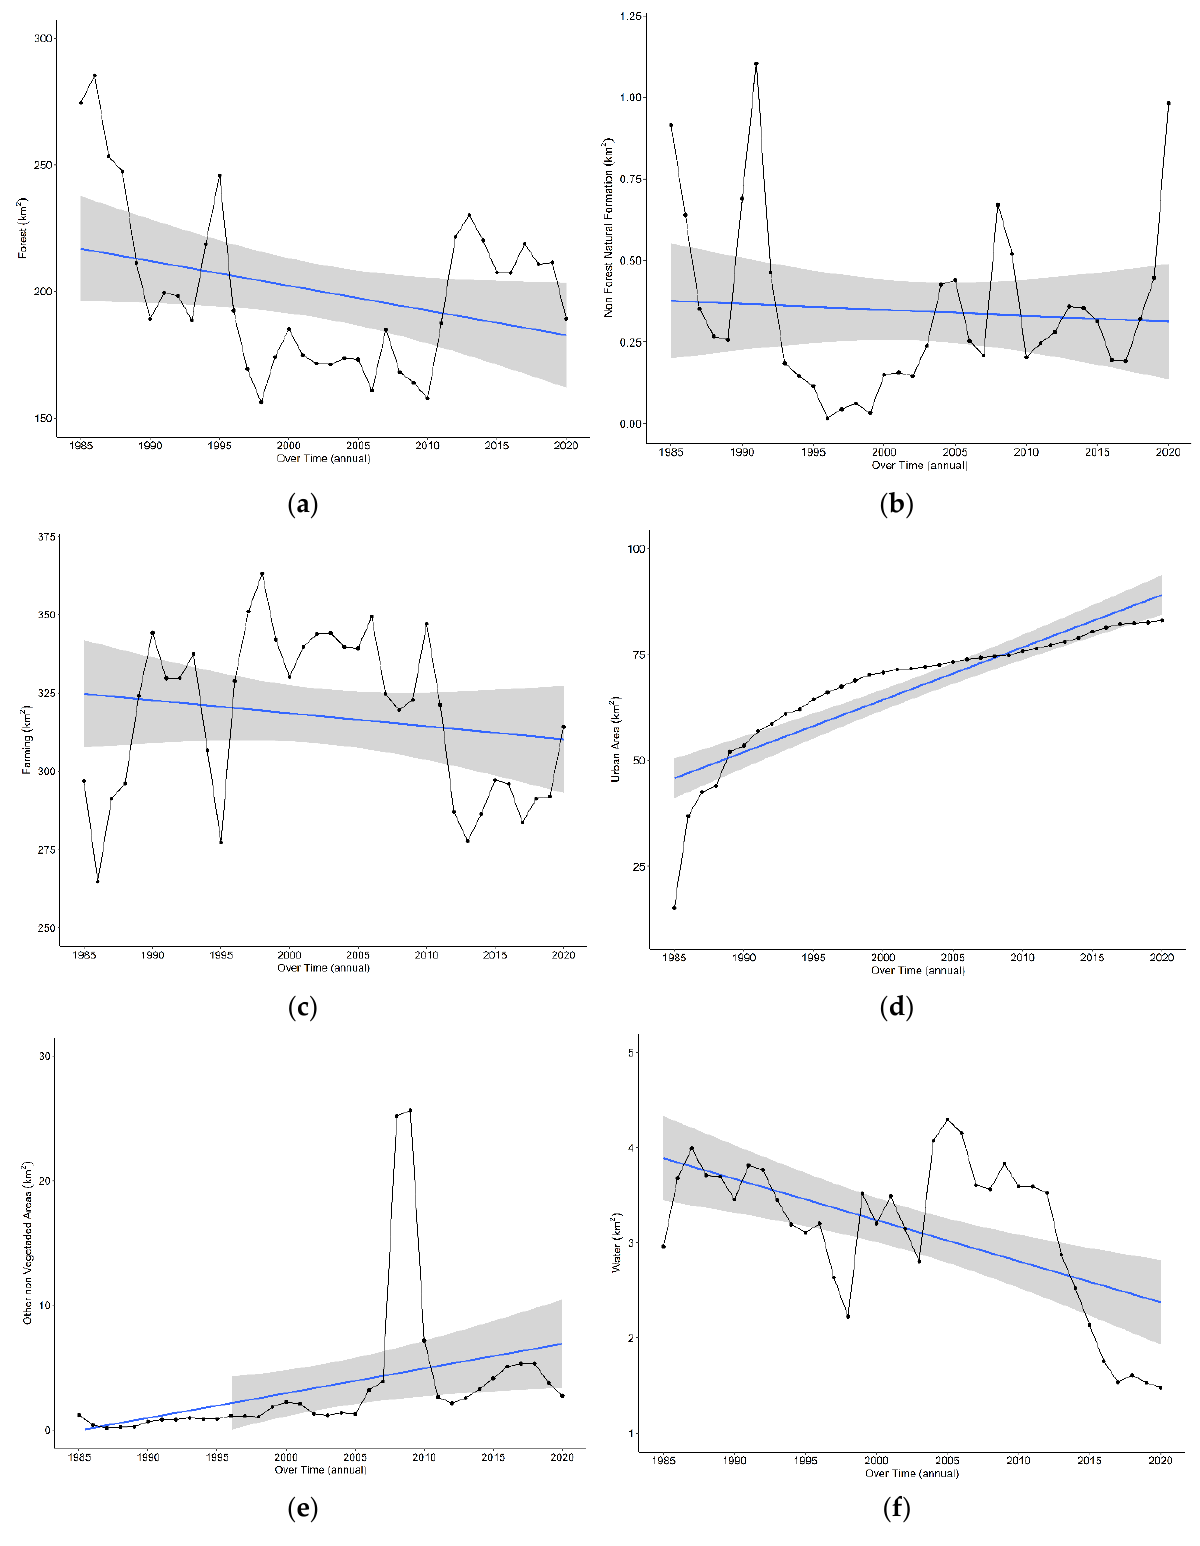
Figure 3. Mann–Kendall trend analysis and Sen estimator for the total annual amount of land cover and land use in the study area (1985–2020). Forest ( a ), non-forest natural formation ( b ), farming ( c ), urban area ( d ), other non-vegetated areas ( e ), and water ( f ). Area shaded in gray corresponds to 95% confidence intervals of the linear trend line.